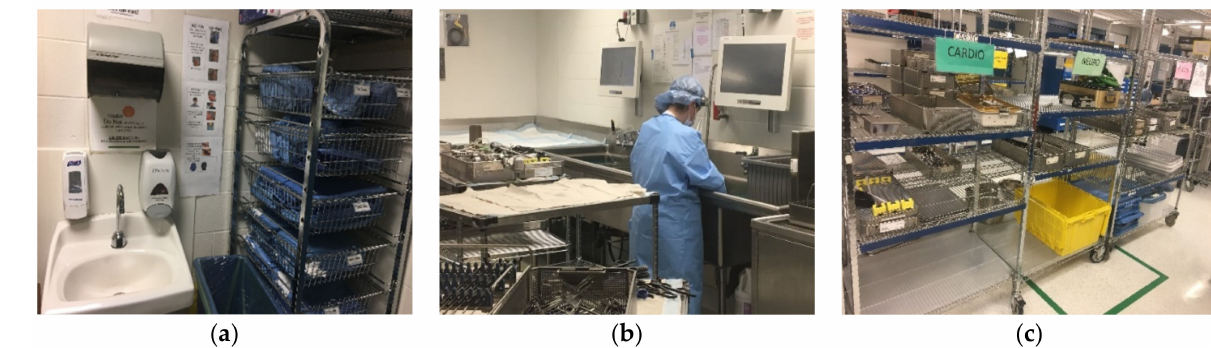
Figure 2. Examples of reprocessing in a high-level medical center: ( a ) Intake area for dirty equipment; ( b ) precleaning of dirty equipment; and ( c ) reprocessed equipment in storage. Images A. White, 2018.